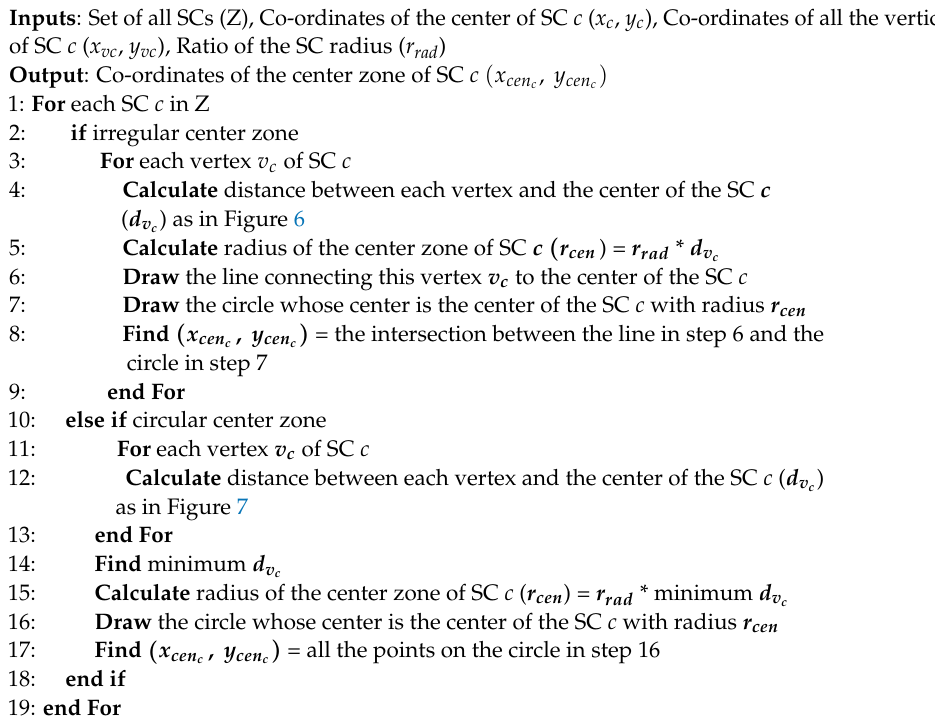
Algorithm 2 : Proposed Circular and Irregular Center Zone